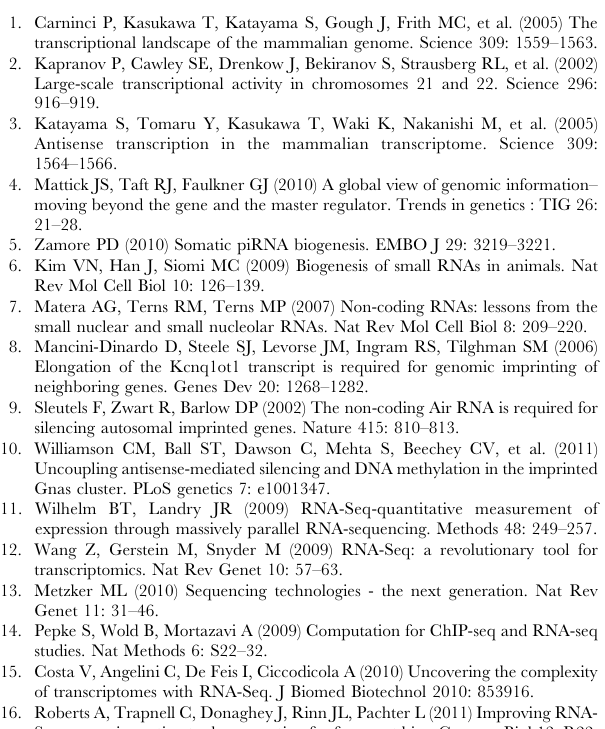
Figure S2 Determining correction factors for the calcu- lation of differentially expressed genes. The number of genes showing expression differences as indicated by the bins on the x-axis was calculated for RefSeq protein-coding genes for the following RiboMinus (RM) datasets (shown in Figure 6B): ( A ) FH- RM – Cui et al. polyA, ( B ) CCE-RM – Cloonan et al. EBs ( C ) Mortazavi et al. adult brain - FH-RM (first tissue is shown on the left, second tissue is shown on the right). Note that the 0 bin contains all genes showing no expression in both datasets. Expression is defined by an expression value larger than RPKM